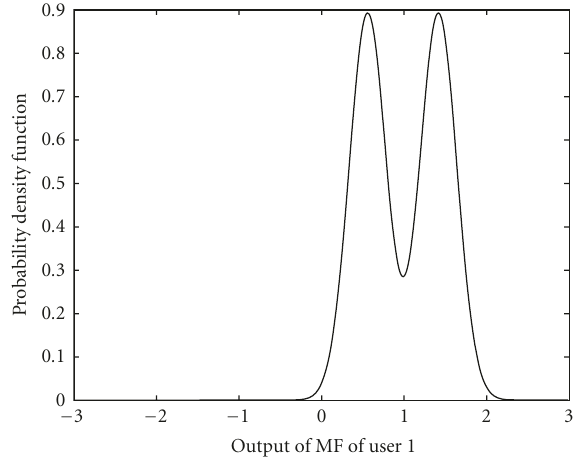
Figure 2: Conditional pdf such as b 1 = +1 of the output of matched filter for user k = 1 and for a SNR = 10 dB .